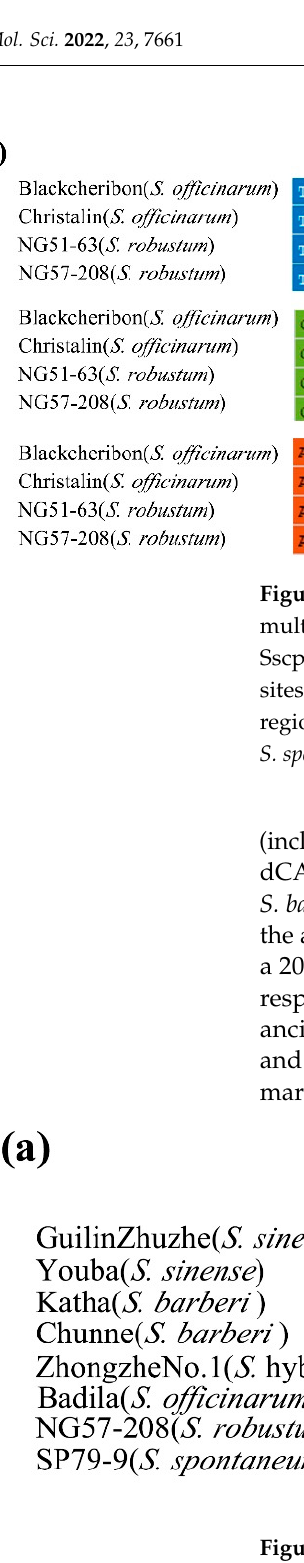
Figure 8. The gel electrophoresis results of the amplification of DNA barcodes using designed primers. ( a ) The multiple alignments of the chloroplast genomes by MAFFT, ( b ) SNP analysis with dCAPS primers, and Sscpd5 designed for the SNP site in rbcL-psaI region with TaqI restriction sites. Abbreviated species names are shown on schematic diagrams, Sb , S. barberi ; Ssi , S. sinense ; Sh , S. hybrid ; So , S. officinarum ; Sr , S. robustum ; Ss , S. spontaneum